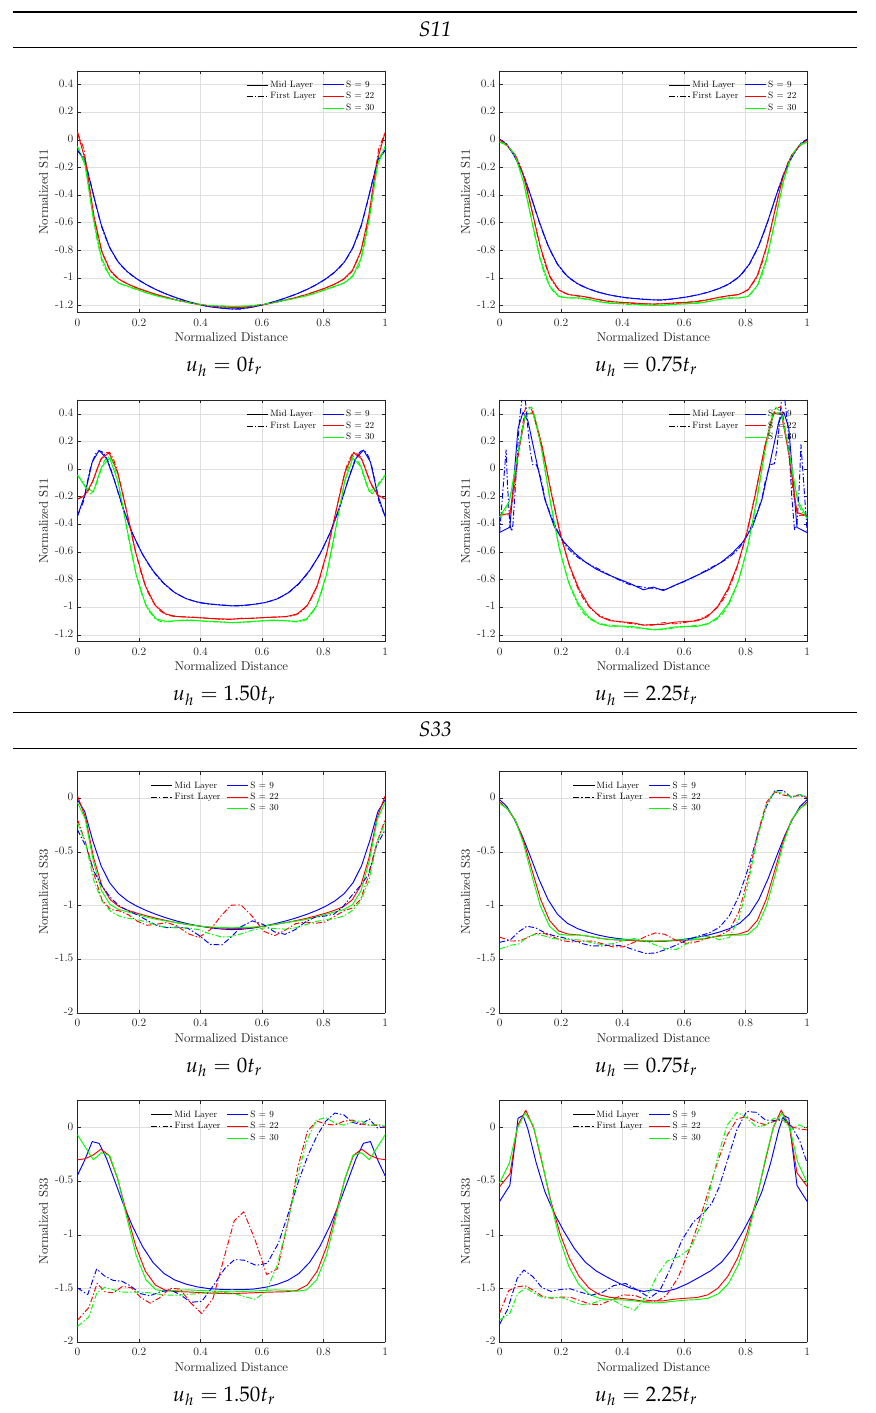
Figure 9. Axial normal stress S11 and vertical normal stress S33 along the symmetry axis. Effect of shape factor S